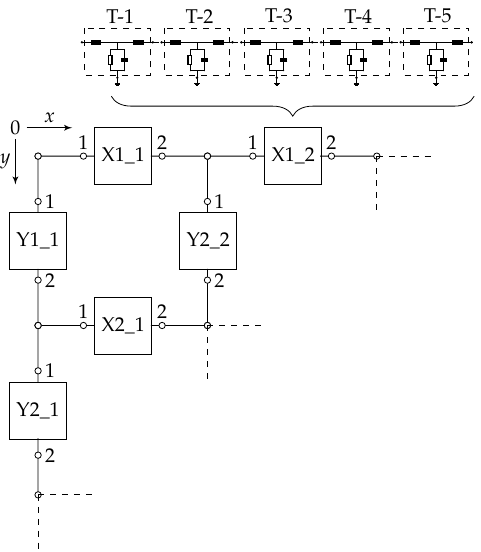
Figure 2. The grounding system layout with formation